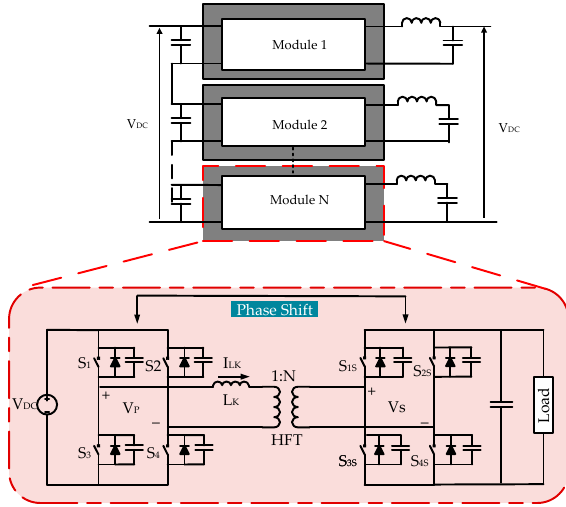
Figure 5. Cascaded